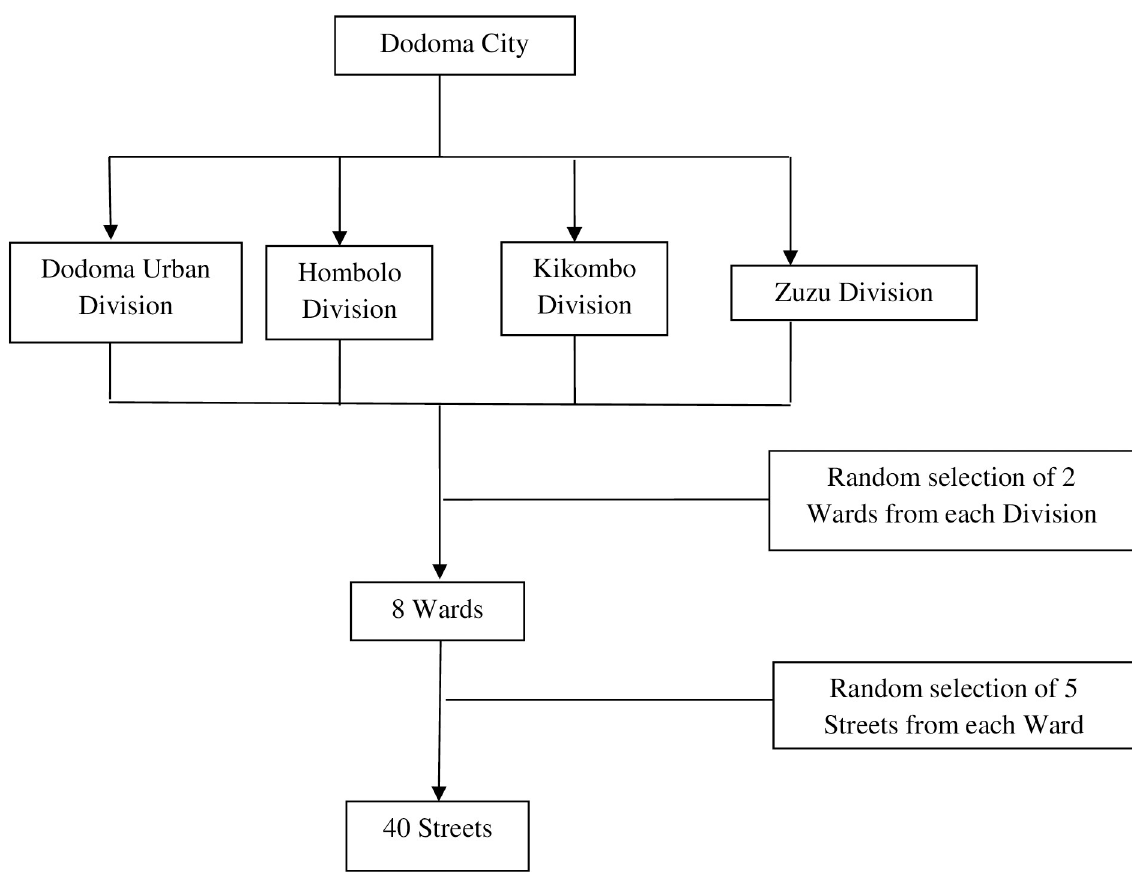
Fig 1. Selection of wards and streets for the